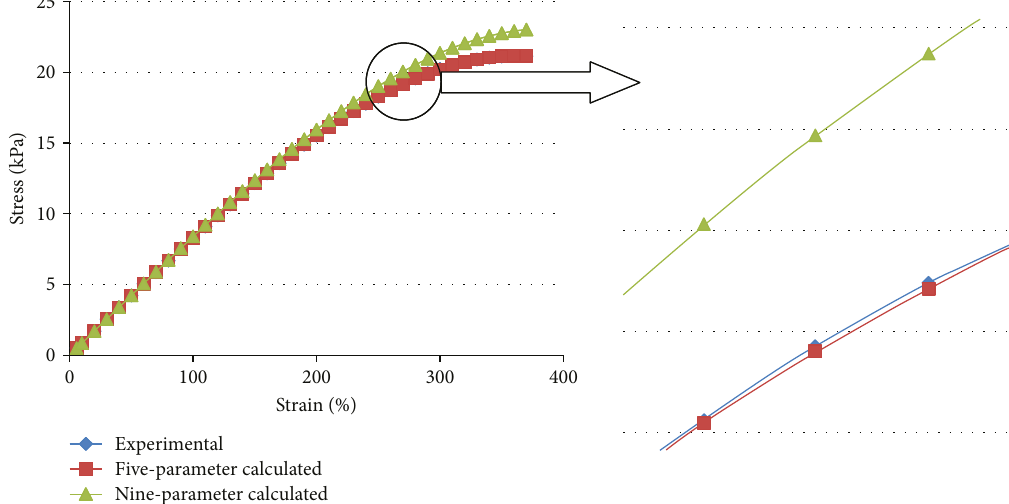
Figure 8: Comparison of the calculated tensile stress with the experimental data from the uniaxial tensile